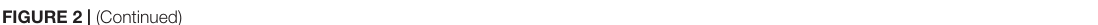
units from 7 rats). Whisker stimulation further increased the probability of functional connections between neuronal pairs that shared the same preferred angle to 36.8 ± 6.4% ( Figure 7C , p < 0.05 compared to the spontaneous pre- stimulus